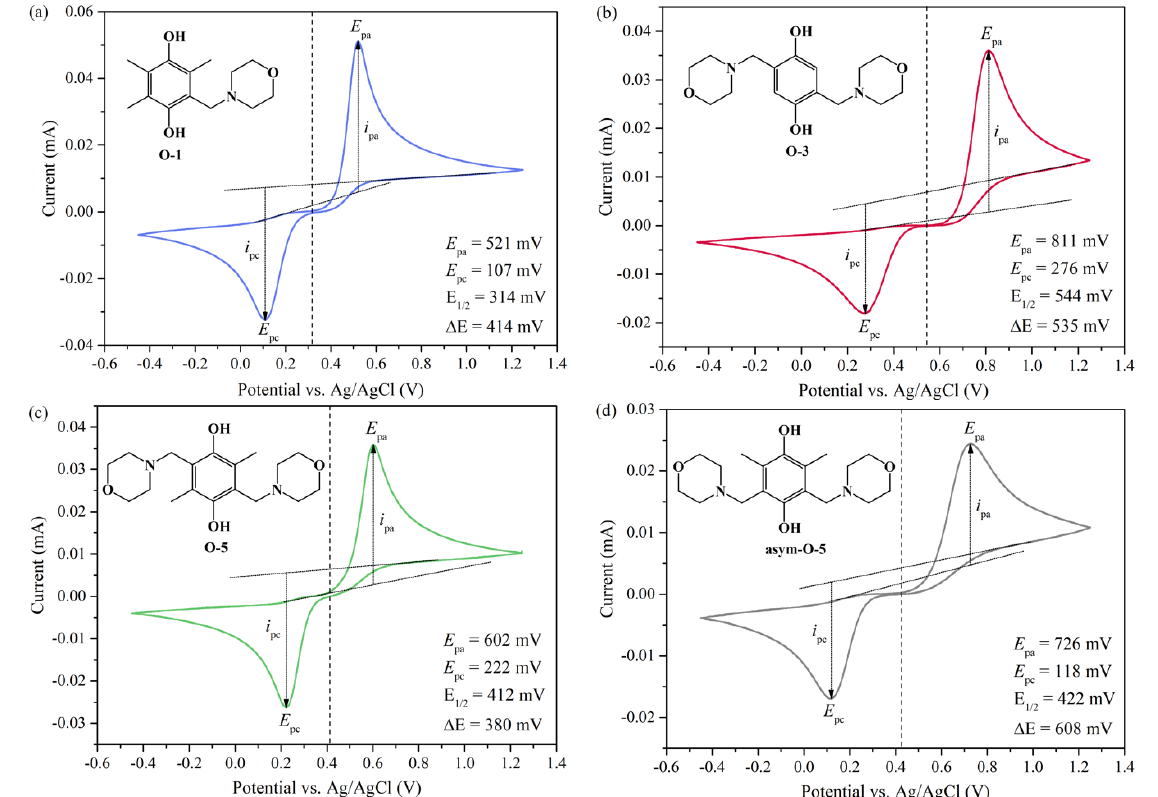
Figure 1. Cyclic voltammographs of hydroquinones ( a ) O-1 , ( b ) O-3 , ( c ) O-5 and ( d ) asym-O-5 measured at a scan rate of 100 mV·s − 1 in 1 M H 2 SO 4 . The chemical structures of the four molecules are presented in the top-left corner of the corresponding subfigures. The dashed line indicates the half-wave potential E 1/2 vs. Ag/AgCl.